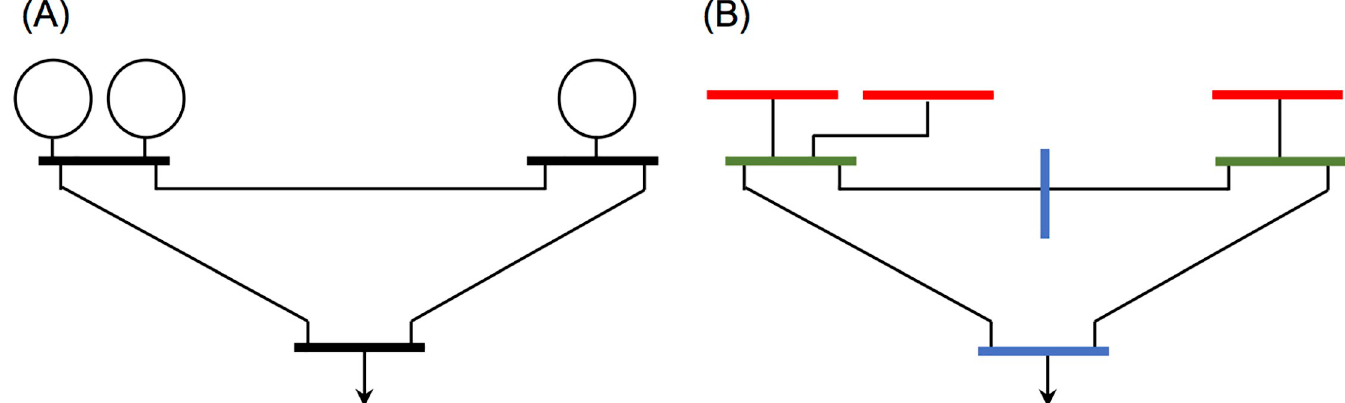
Fig 2. Schematic one-line diagrams of (A) the IEEE 3-bus system and of (B) the system with three Ibuses (in red), two Kbuses (in green), and two Mbuses (in blue).